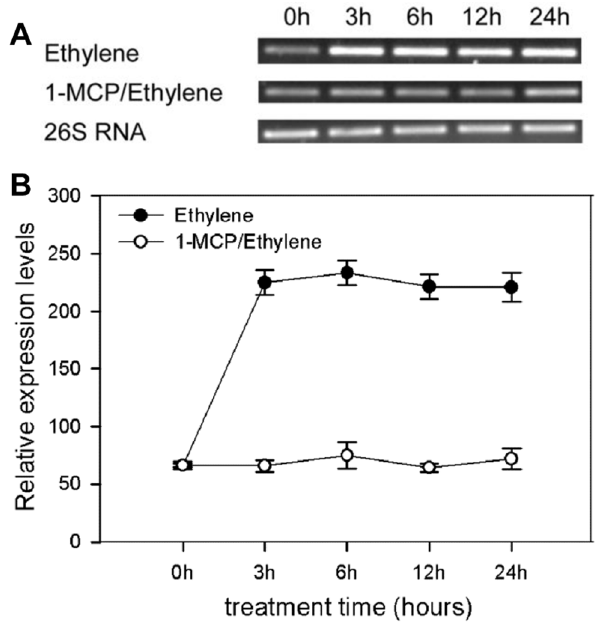
Figure 3. Expression of PhHD-Zip in petunia flowers in response to ethylene and 1-MCP treatments. ‘‘ Ethylene ’’ Flowers harvested at anthesis and treated continuously with ethylene (3 ppm), ‘‘ 1-MCP/ Ethylene’’ Flowers harvested at anthesis and treated with 1-MCP (50 nL/L) for 4 hours before a continuous ethylene treatment. A. A representative gel image from semi-quantitative PCR of RNA isolated from corollas harvested at intervals. 26S RNA: the internal control. Samples were analyzed after 30 cycles for PhHD-Zip and after 24 cycles for 26S RNA . B. Relative expression levels of PhHD-Zip (quantification of the gel pictures; error bars show SE of the means of three biological replicates).